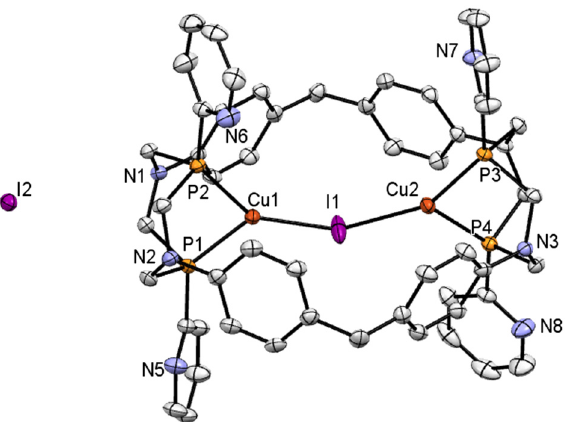
Figure 1. Geometry of complex 3 in a crystal. Solvate DMF molecules and hydrogen atoms are not shown for clarity. Ellipsoids of anisotropic displacements are given with a probability of 50%. The metal ions are both trigonal planar (the sums of bond angles are 358.5–360 ◦ ). Each fragment in the P,P-chelate mode, and these ions are additionally bound by a